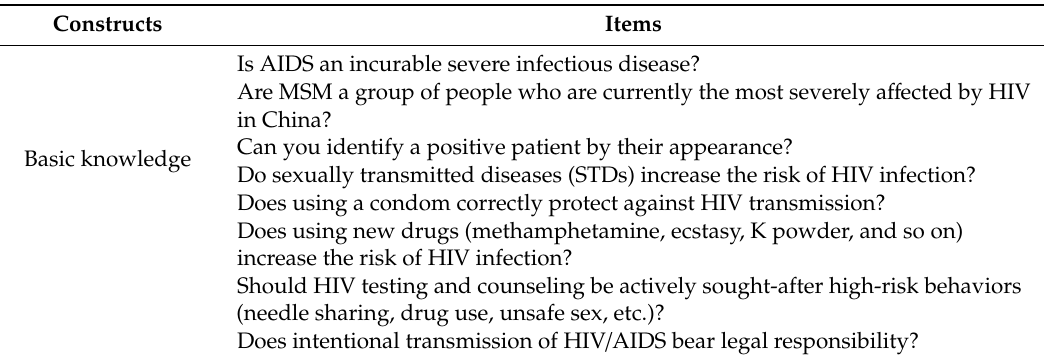
Table 1. Constructs of basic HIV / AIDS